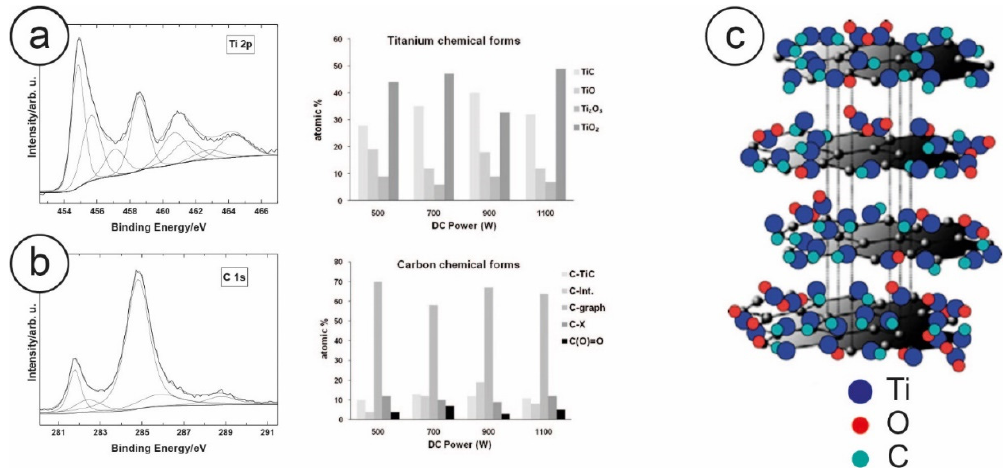
Figure 5. The distribution of the oxides in the layer was determined from the X-ray Photoelectron Spectroscopy (XPS) spectra of the film by investigating the Ti2p region, while the carbon species was obtained by studying the C1s spectra (panels a and b ), both taken with Al k α monochromatized radiation, and the relative abundance histograms. This allows us to propose the reported pictorial model ( c ) of the TiC-enriched layer, where Ti oxides (TiO 2 ), TiC and graphitic carbon are strictly connected to form a cluster as a consequence of the deposition conditions adopted. Reprinted from